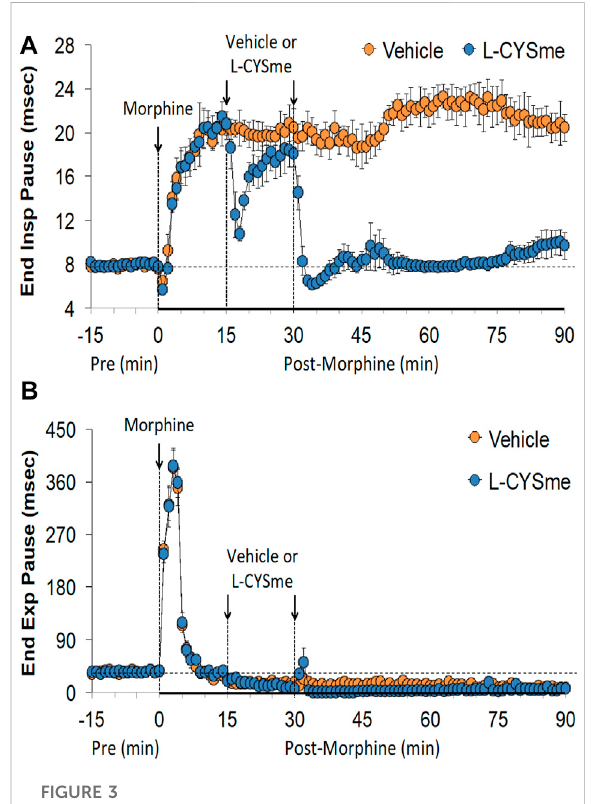
FIGURE 3 End inspiratory pause Panel (A) and end expiratory pause Panel (B) prior to (Pre), following the injection of morphine (10 mg/kg, IV), and then two injections of vehicle or L-cysteine methyl ester (L-CYSme, 500 μ mol/kg, IV) given 15 min apart, in freely-moving rats. The data are presented as mean ± SEM. There were 6 rats in each group.